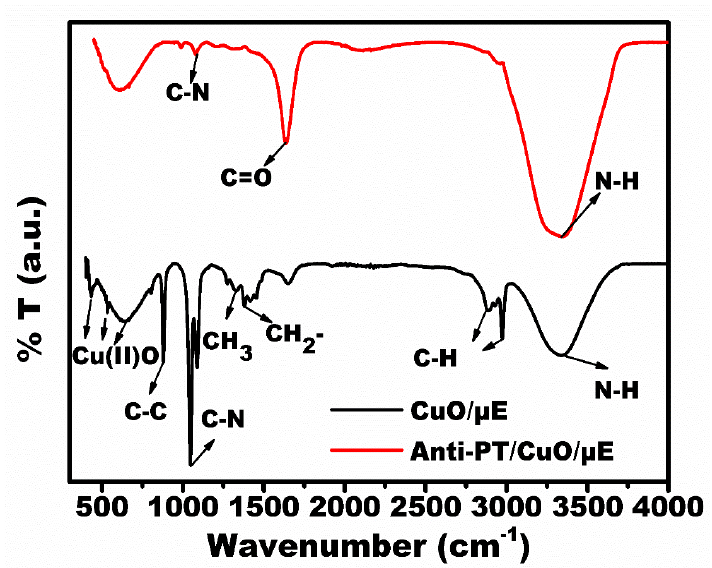
Figure 3. FTIR spectral analysis of the developed sensor (Anti-PT/CuO/Au-µE).